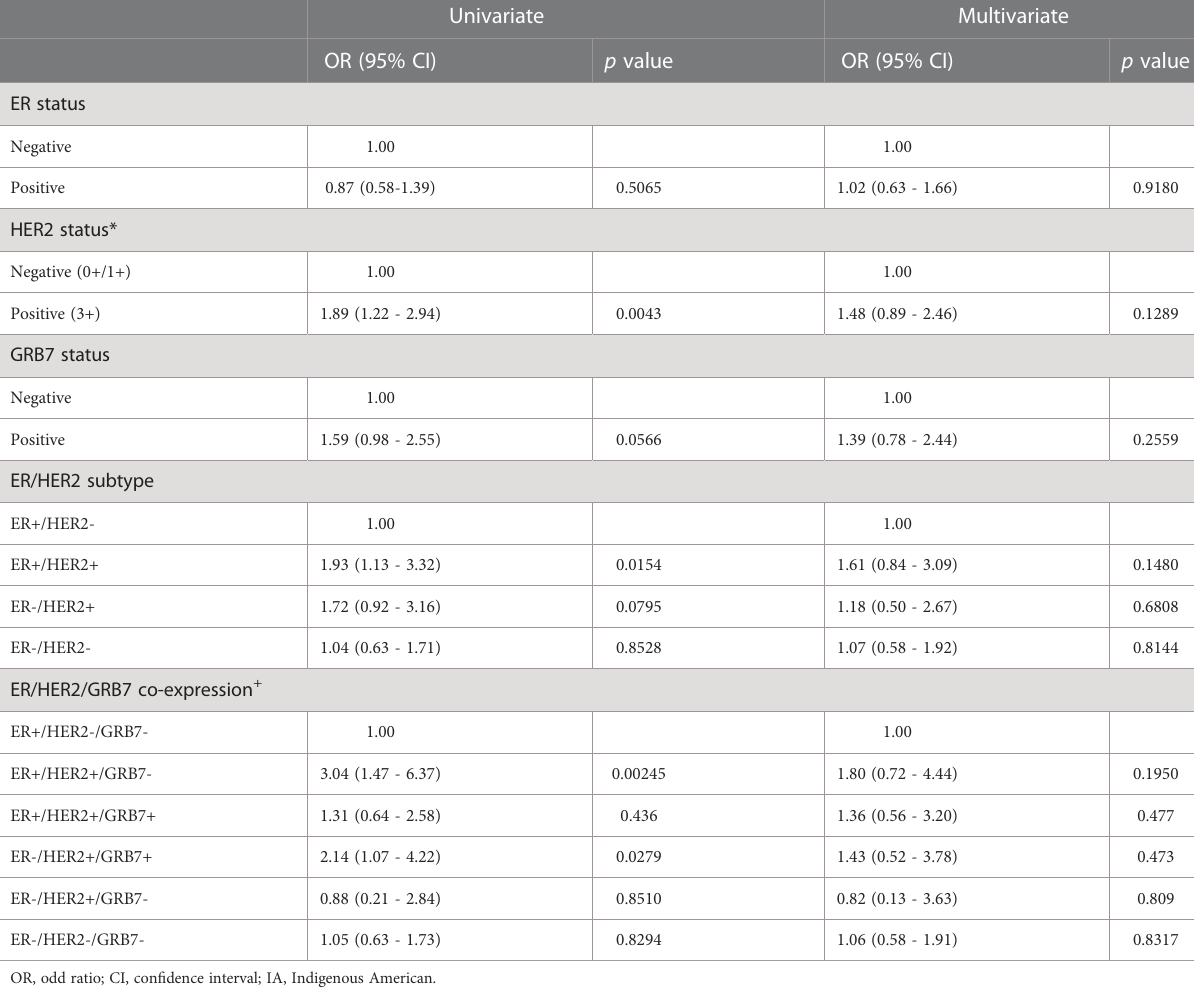
TABLE 3 Association per every 25% increase in IA ancestry with ER/HER2/GRB7